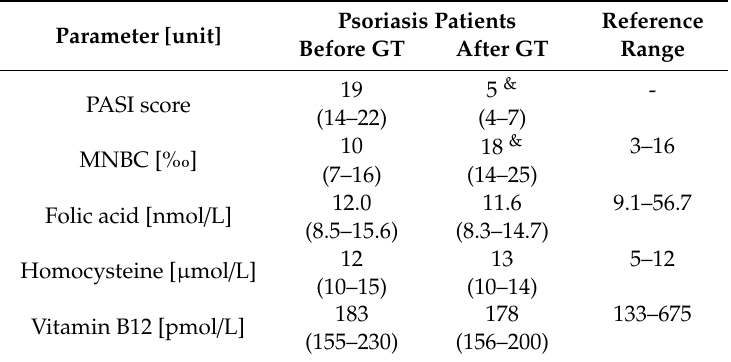
Table 1. Values (and interquartile ranges) of the investigated parameters.